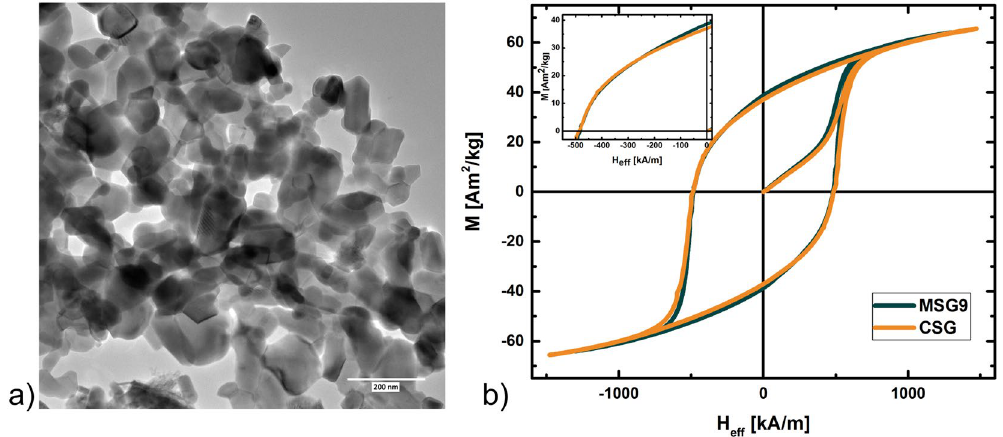
Figure 1. ( a ) TEM image of CSG synthesised SrFe 12 O 19 . The scale is 200 nm. ( b ) Hysteresis curves of the powder samples MSG9 and